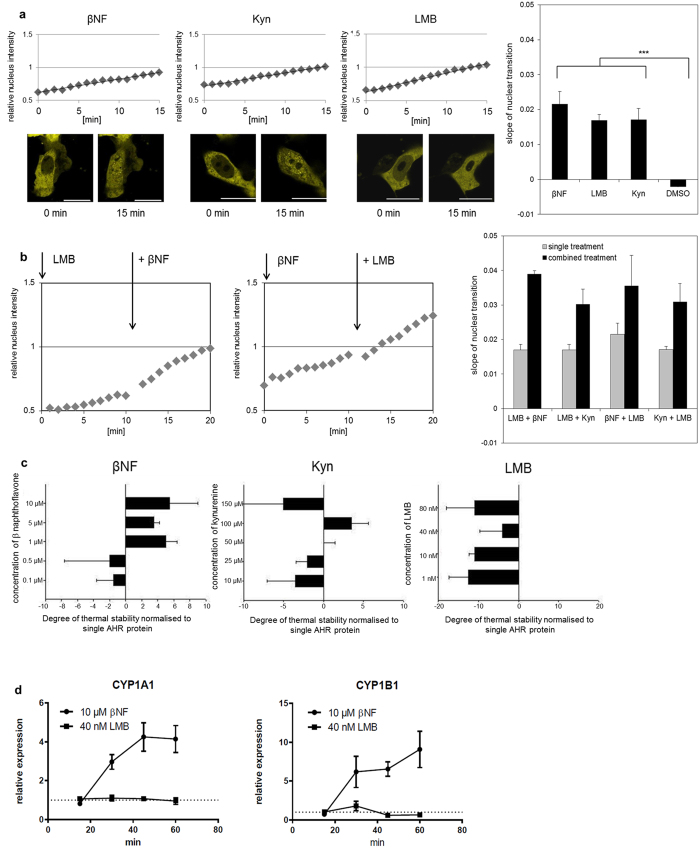
Constitutive nucleocytoplasmic shuttling of the AHR is accelerated by ligands.(a) Fluorescence images demonstrating the translocation of the full-length EYFP-AHR into the nucleus in HepG2 cells after treatment with 10 μM β-naphthoflavone (βNF), 100 μM kynurenine (Kyn) and 40 nM leptomycin B (LMB) for 15 min (scalebar = 20 μm). The selection of these concentrations was based on a dose-response analysis (Supplementary Fig. S2b). Graphs in the diagrams visualise the shift of nuclear staining in relation to total fluorescence of the analysed cells over 15 min. All three compounds triggered a comparable transition of EYFP-AHR into the nucleus, as indicated by comparable slopes of the graphs. Each bar (right diagram) represents the mean of at least 10 analysed cells +/− S.E.M. ***p < 0.001. (b) βNF accelerates the basal nucleocytoplasmic shuttling. Cells were treated for 10 min with 40 nM LMB, co-treated for another 10 min with 10 μM βNF (left side). Nuclear transition of EYFP-AHR was recorded and analysed as described above. Nucleocytoplasmic shuttling continues in the presence of ligand. Cells were treated with 10 μM βNF for 10 min, then co-treated with 40 nM LMB and analysed as described above (middle). Slopes of the recorded graphs were separately determined for single and combined treatments as indicated (right side). Each bar represents the mean of at least 10 cells +/− S.E.M. (c) Thermal shift assay with purified recombinant human AHR (protein purification is summarised in Supplementary Fig. S4). Shown is the relative thermal stability of AHR in the presence of LMB, Kyn and βNF at different concentrations. Compared to unliganded AHR, βNF and Kyn increased thermal protein stability, while LMB apparently has a destabilising effect. A decrease of stability was noted using 150 μM Kyn, possibly triggered by precipitation. Shown are the means of three biological replicates +/− S.E.M. (d) Time-dependent transcriptional activation of CYP1A1 and CYP1B1 in HepG2 cells. Induction was only seen after treatment with 10 μM βNF but not with 40 nM LMB. Displayed values represent relative inductions of transcripts normalised to the solvent control. Values shown are means of three biological replicates +/− S.E.M.